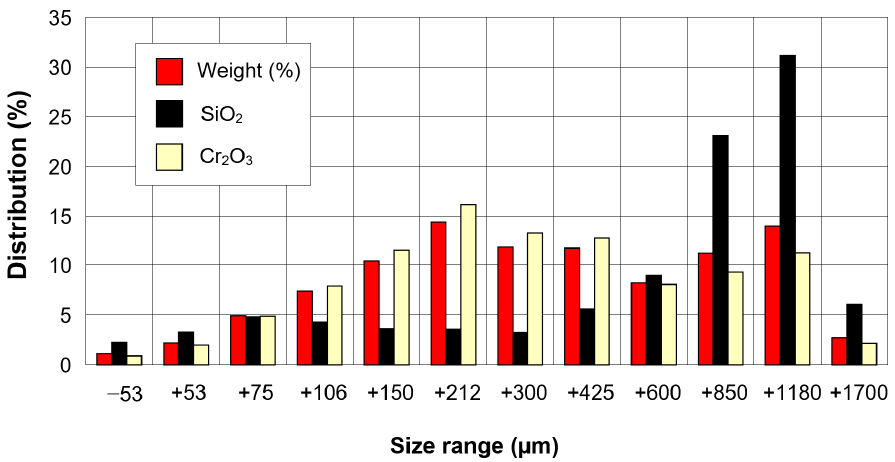
Figure 1. SiO 2 and Cr 2 O 3 distribution by size for the − 2 mm bulk chromite